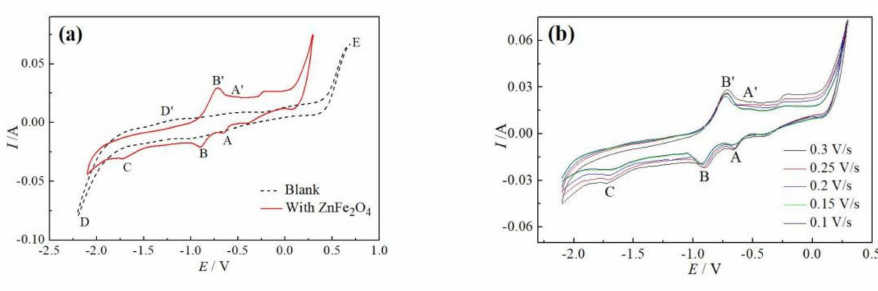
Figure 4. CV curves on Mo electrode at 800 ◦ C ( a ) a scan rate of 0.3 V · s − 1 and ( b ) with different scanning rates (0.1 V · s − 1 ~0.3 V · s − 1